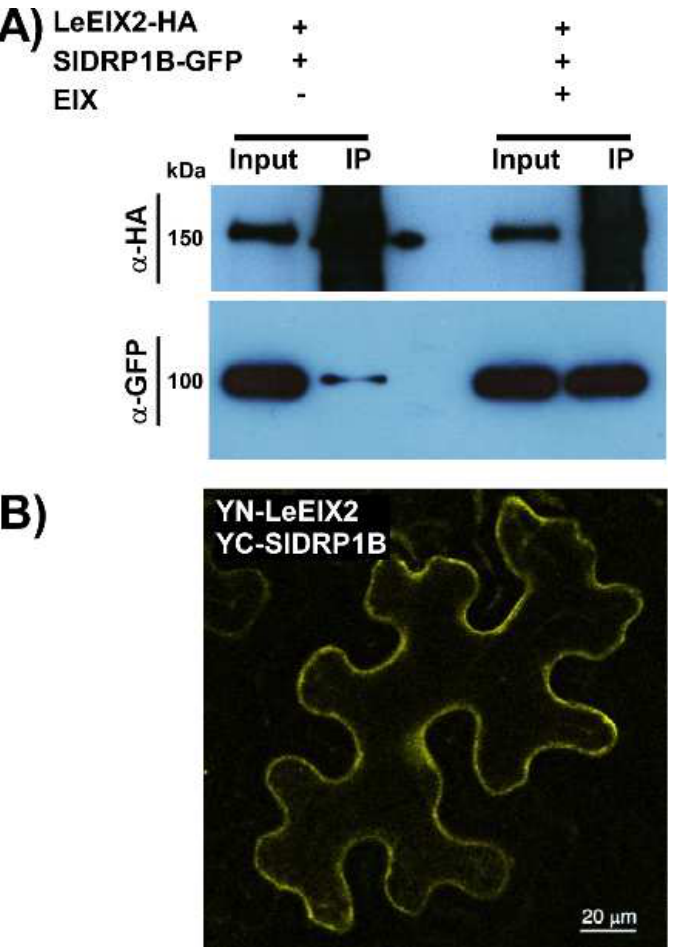
Figure 3. SlDRP1B associates with LeEIX2. ( A ) N. benthamiana was transiently transformed with LeEIX2-HA and SlDRP1B-GFP. Leaves were harvested and treated with EIX or water (mock). Input and immunoprecipitated samples were subjected to SDS-PAGE and immunoblot with anti-HA anti- bodies to detect LeEIX2-HA, and anti-GFP antibodies to detect SlDRP1B-GFP. ( B ) BiFC visualization of the association between LeEIX2 and SlDRP1B. N. benthamiana leaves transiently expressing YN- LeEIX2 cytoplasmatic domain and YC-SlDRP1B as indicated. Leaf sections were visualized using a laser-scanning-meta confocal microscope. Scale bar 20 µ m. To examine the effect of SlDRP1B overexpression on ROS burst and ethylene produc- tion elicited by EIX, we transiently expressed SlDRP1B in N. tabacum cv Samsun NN (EIX responsive cultivar) followed by EIX application. SlDRP1B enhanced LeEIX2-mediated defense responses compared to control, leading to an increase in ROS burst and ethylene production (Figure 4). Based on bioinformatic analysis, we mutated the GTPase active site (Lysine 47 to Alanine, SlDRP1BK47A), creating a predicted loss of function. The mutated form lost the ability to enhance EIX-mediated defense responses, effecting a decrease in EIX-dependent ROS burst (Figure